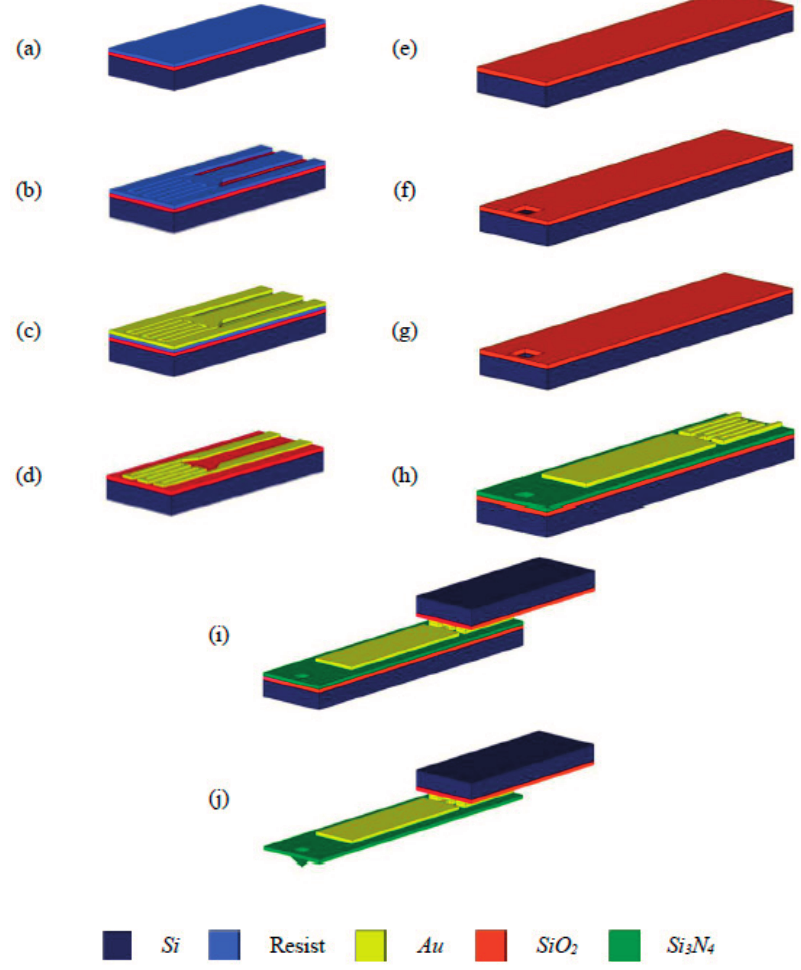
Figure 3. 3-D isotropic view of the micro-cantilever fabrication scheme: ( a ) deposition of resist layer on oxidized (SOI) wafer; ( b ) resist layer patterning for interconnect metal; ( c ) Cr/Pt/Au (30/60/1000 nm) layer deposition; ( d ) Au lift-off; ( e ) oxidation of Si (SOI) wafer; ( f ) SiO 2 patterning; ( g ) anisotropic Si etch; ( h ) Si 3 N 4 deposition and its patterning, lift-off resist patterning, and Cr/Pt/Au (30/60/400 nm) deposition and lift off; ( i ) Au-Au thermal compression bonding; and ( j ) Si release (TMAH etch: Si mold wafer etch and Si handle